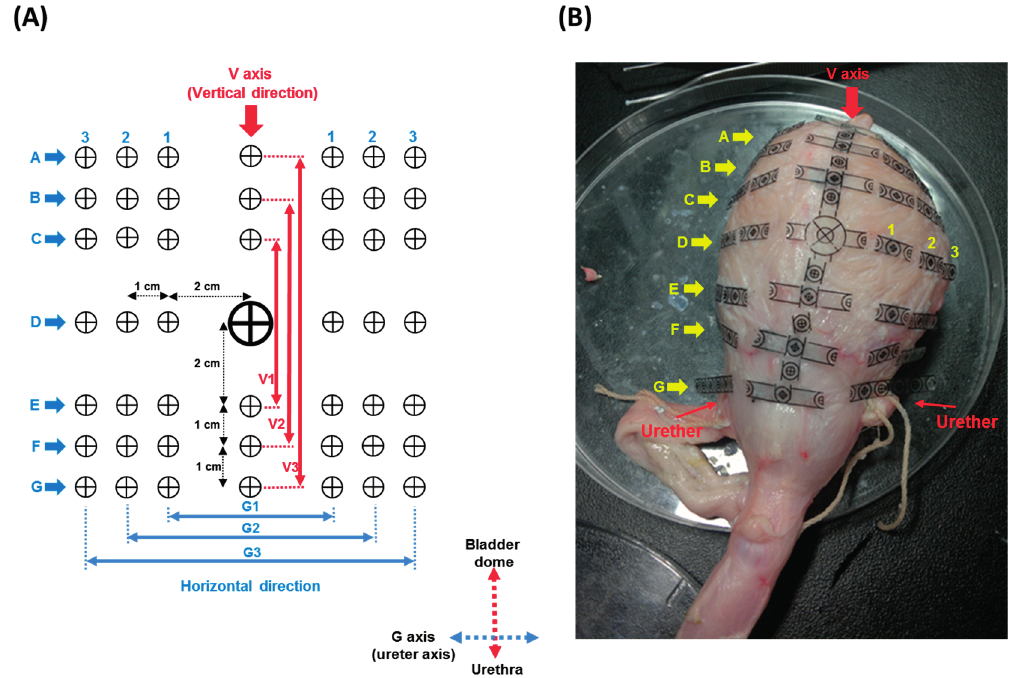
Figure 3. Geometric relationship between the bladder capacity and bladder wall length as quantified by a marker array label system. ( A ) The marker array consisted of one vertical axis (V axis) and seven horizontal axes (from A–G), in which each axis had three measured intervals; e.g., Axis G comprised the G1, G2 and G3 intervals; ( B ) each marker point was stuck onto the outer dorsal bladder wall with tissue adhesive. Axis G was defined as the line of two ureter points, and Axis V was defined as the midline of the dorsal bladder wall. The relationship between the bladder capacity and bladder wall length was established by repeatedly filling the pig bladder with saline from 0–500 mL in